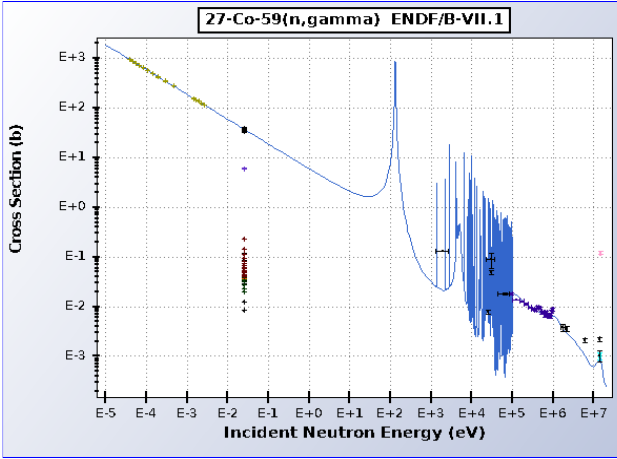
Fig. 7. The energy dependence of cross-section of reaction n + 59 Co → γ + 60g,m Co [14]. Neutron activation of 59 Co leads to the formation of 60g Co in the ground state and in the isomeric state 60m Co. The decay schemes of cobalt from the ground (T 1/2 =5.27 years) and isomer (T 1/2 =10.47 minutes) states [9] are shown in Fig. 7. Isomer state has two decay modes – 99.76% isomeric gamma transition with E γ =58.59 keV and 0.24% β - decay. The ground state is a well- known standard cobalt- source which after β - decay gives